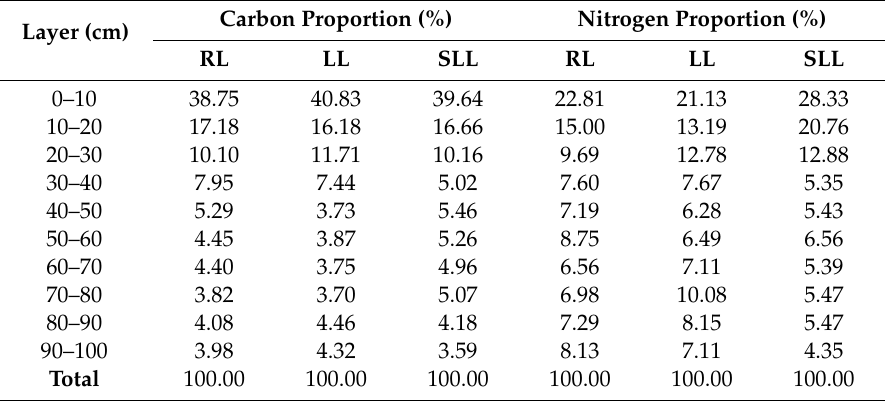
Table 9. Carbon and nitrogen distributions in the soil layer.